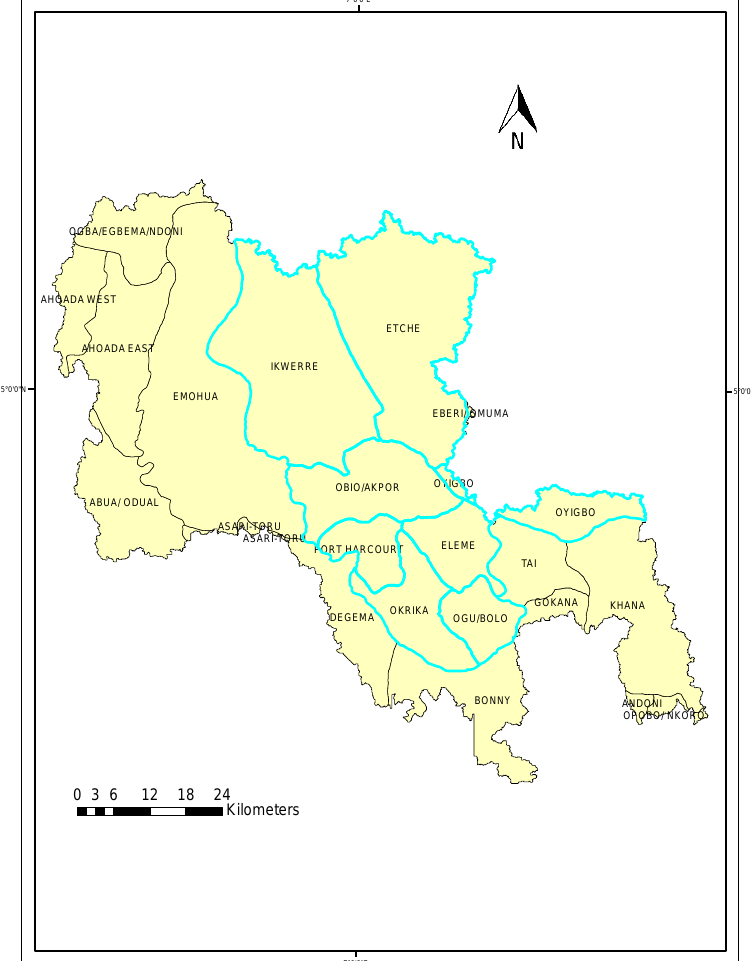
Figure 1. Map of the entire Watershed under study. Areas bordered with green lines are the administrative areas of Greater Port-Harcourt in River State, Nigeria.